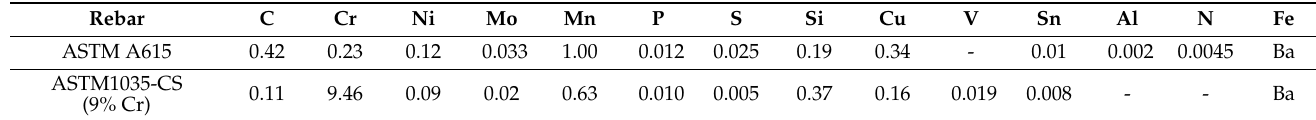
Table 1. Chemical compositions of ASTM 615 and ASTM1035 steel rebar (in wt%).